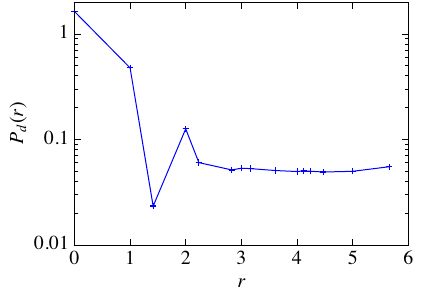
FIG. 11. Superconducting correlation function P function of pair-pair distance r . The cross data points also contain (very small) error